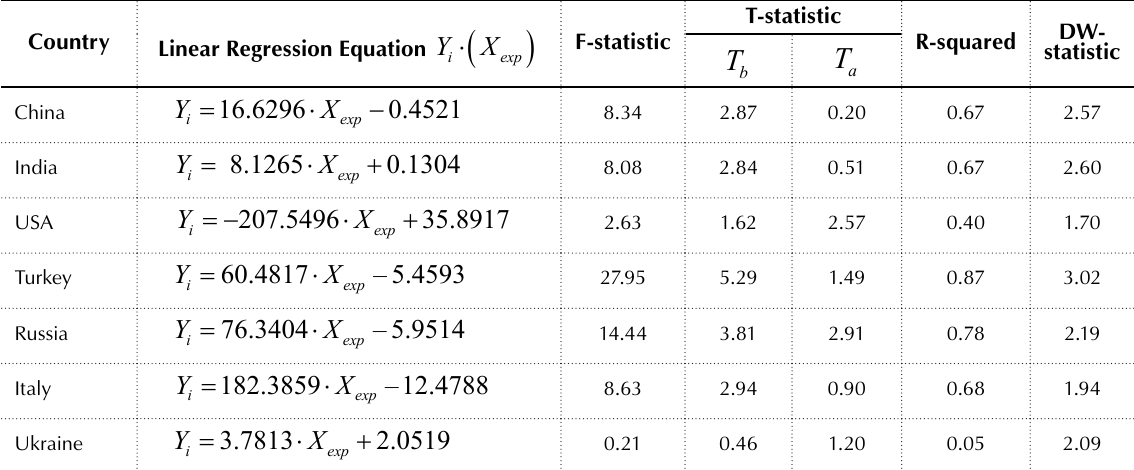
Country Linear Regression